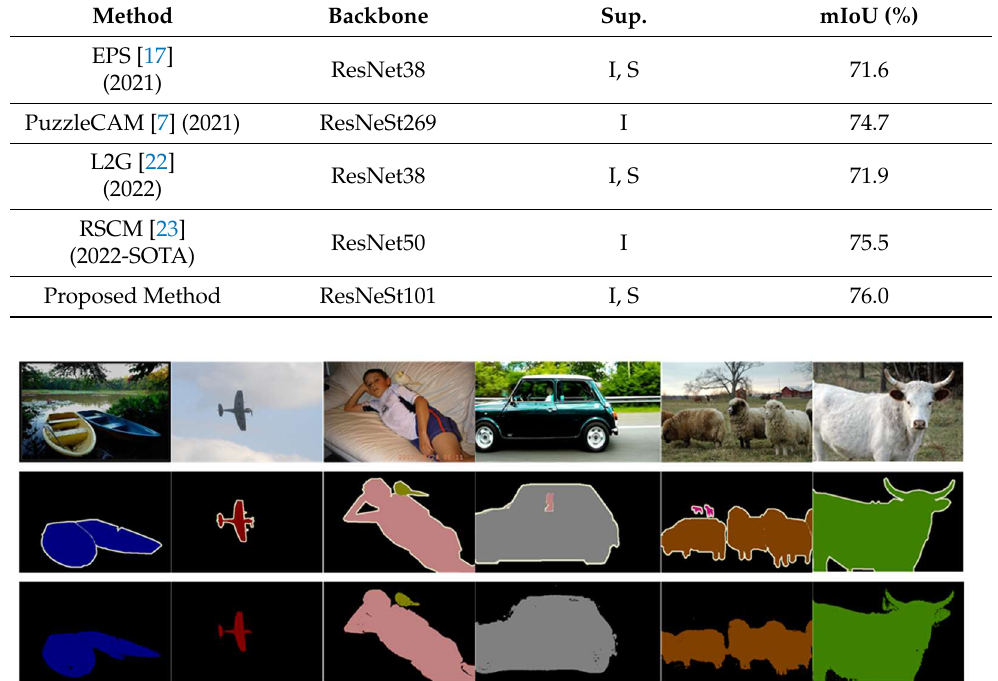
Table 5. Comparison of pseudo masks generation results with other existing method in MIOU (%).